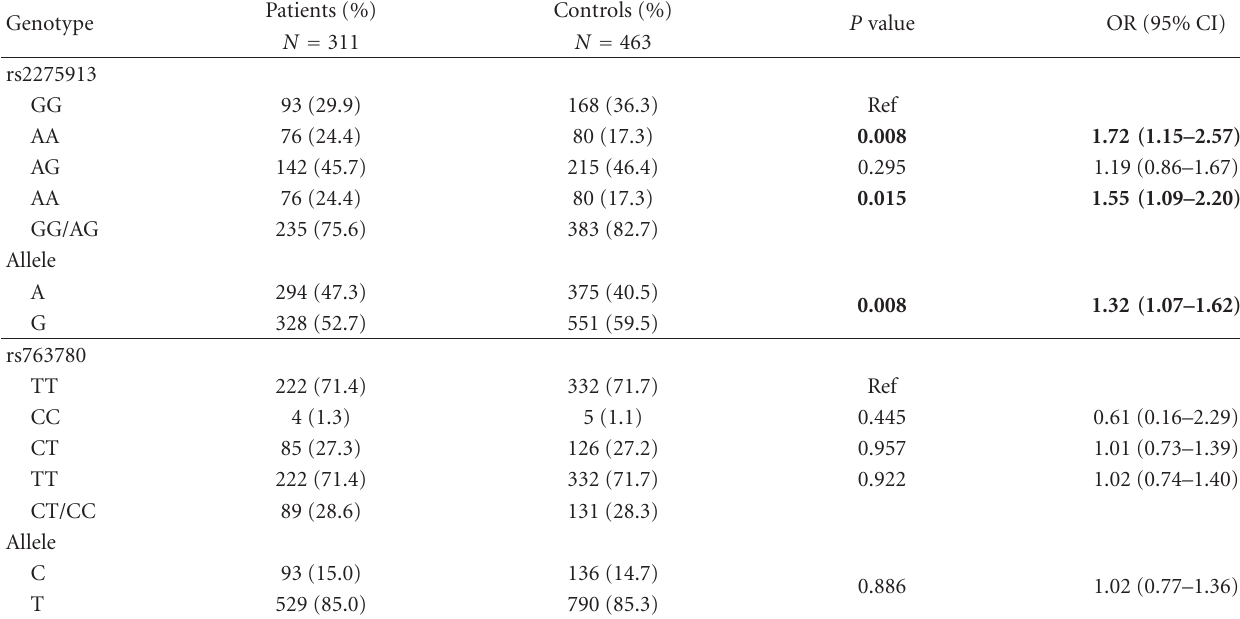
Table 1: Genotype and allele distribution of two single-nucleotide polymorphism loci in cervical squamous cell carcinoma patients and